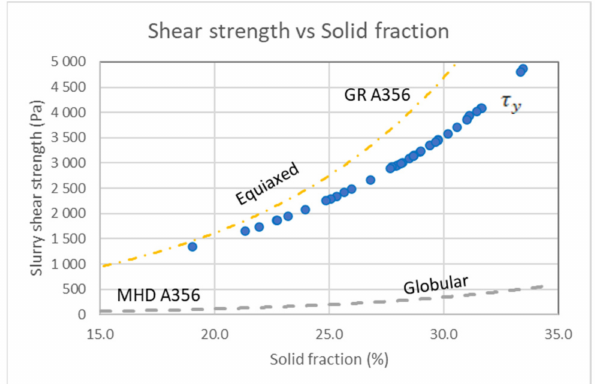
Figure 7. Illustration of the factors influencing the static behaviour with the shear strength, τ y , and the structure corrected shear strength compared to the data from Pan et al. [7] for the equiaxed GR A356 (dash-dotted line) and the more globular MHD A356 (dashed line)